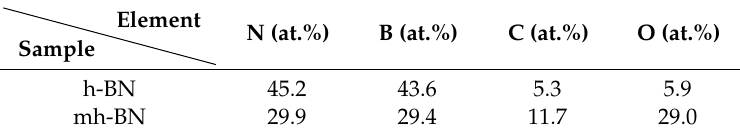
Table 1. Chemical composition of unmodified (h-BN) and plasma-modified (h-BN50) nanoparticles obtained from XPS